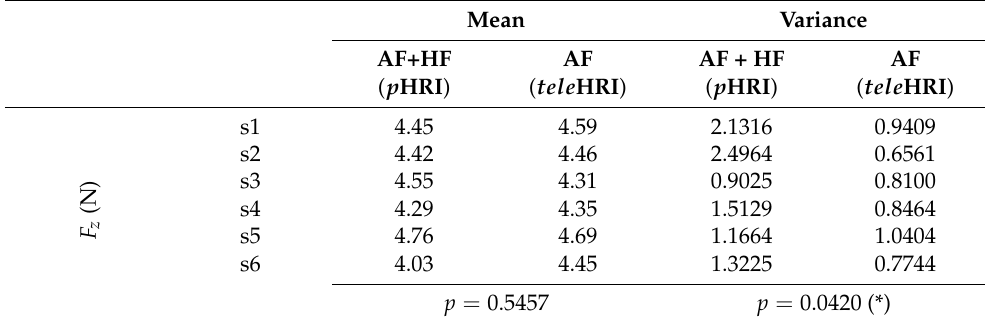
Table A2. Time percentage for keeping force within desired range under different feedback types in two modes when the proposed hybrid controller is NOT implemented in Experiment 1.